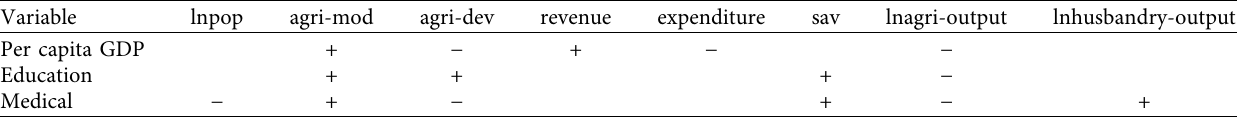
Table 4: DID dynamics test results of various control variables on economic growth and public service development. Variable